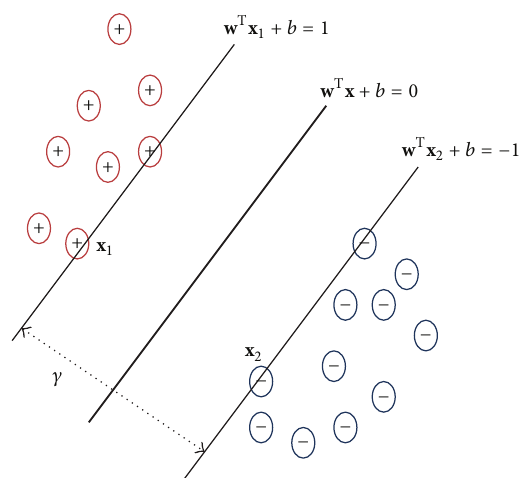
Figure 3: The separating hyperplane ( w T x + 𝑏 = 0 ) splits x 𝑖 vectors into two classes, vectors labeled with y = 1 in one side and y = −1 on the other side. x 1 and x 2 are samples of support vectors of opposite sign. The canonical hyperplanes pass through the support vectors. The region between them is the margin band 𝛾